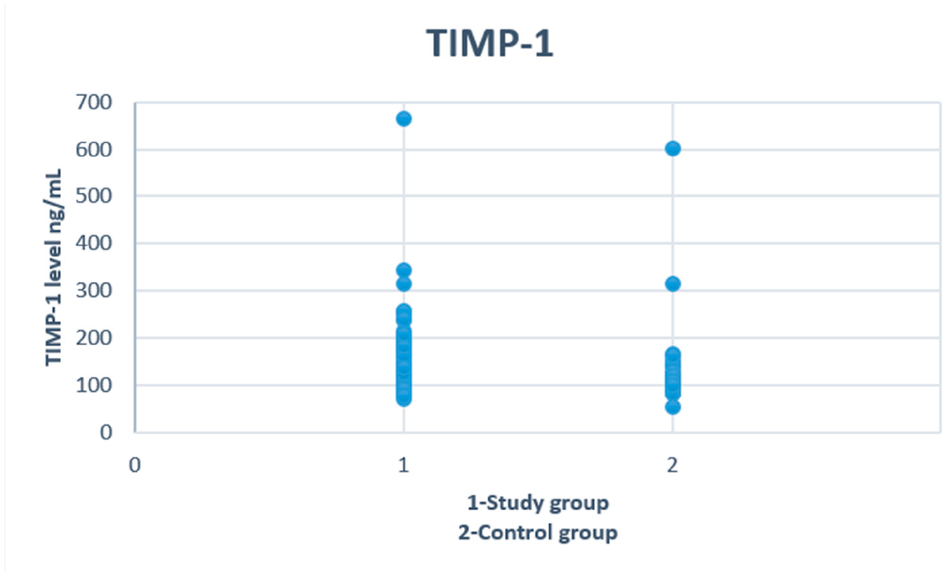
Figure 2. Serum concentrations of TIMP-1 in study and control groups. Table 1. Characteristics of the study and control groups.